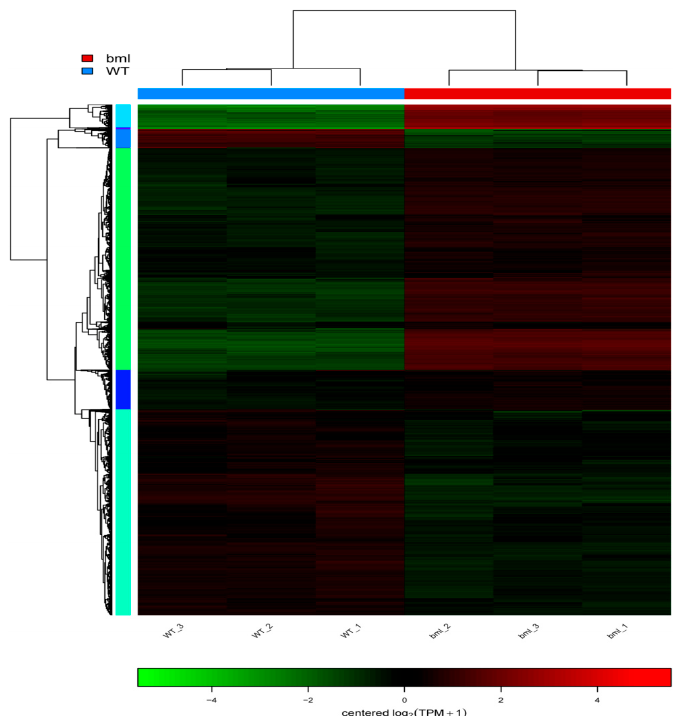
Figure 7. Clustering heat map of differential gene expression. Each row in the Figure represents a gene, each column represents a sample, and the color indicates the amount of expression of the gene in the sample. Red indicates that the gene is expressed in the sample, and green indicates that the expression level is low. The left side is a tree diagram of gene clustering. The closer the two gene branches are, the closer they are. The upper part is the tree diagram of the sample cluster, and the lower part is the name of the sample; the two samples are separated. The closer it is, the closer the expression patterns of all the genes in these two samples are, i.e., the closer the trend of gene expression changes. In total, 4101 genes which exhibited diverse expression patterns between the bml mutant and WT were classified into 10 sub-clusters, (Figure 8 and Table S8). Six clusters showed the changes of gene expression, while 4 exhibited genes with up-regulation, and 2 contained genes with down- regulation in bml . We found that the genes presented in the clusters were associated with senescence, and most genes showed up-regulation in the bml mutant. Among the up-regulated genes, 139 encoded kinase family proteins, and 19 belonged to receptor-like genes. Additionally, 55 genes were annotated as transcription factors or DNA-binding factors, 17 with WRKY transcription factors, while the rest showed orthology to bZIP , NAC and zinc finger transcription factors (Table S8).